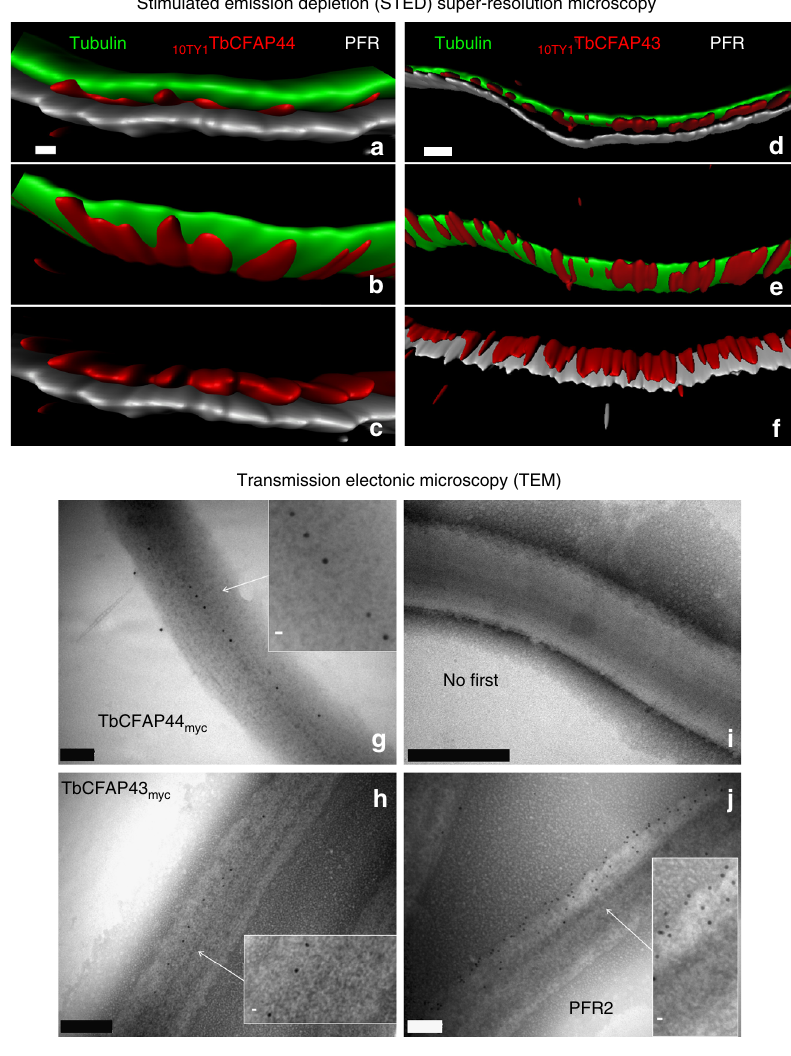
Fig. 7 Orthologs of T. brucei TbCFAP44 and TbCFAP43 are fl agellar proteins apposed to DMTs 5 – 6. a – f STED confocal microscopy, deconvolution, and 3D reconstruction views of the co-labeling, on permeabilized whole cells, of tubulin (green), PFR2 (gray), and 10TY1 TbCFAP44 ( a – c ) and 10TY1 TbCFAP43 ( d – f ) showing that TbCFAP44 and TbCFAP43 are facing the PFR and are closely associated with the tubulin, which likely corresponds to DMTs 5 – 6. Scale bars = 0.5 μ m. g – j Electron immunogold labeling of cytoskeleton-extracted cells expressing TbCFAP44myc ( g ) and TbCFAP43myc ( h ). Controls with no primary antibody ( i ) and anti-PFR2 ( j ). Gold beads size was either 6 nm ( g , h ) or 10 nm ( i , j ). Scale bars = 200 nm in g , h ; 100 nm in i , j . Insets are enlargement of images of fl agella taken from the main panels and scale bars = 10